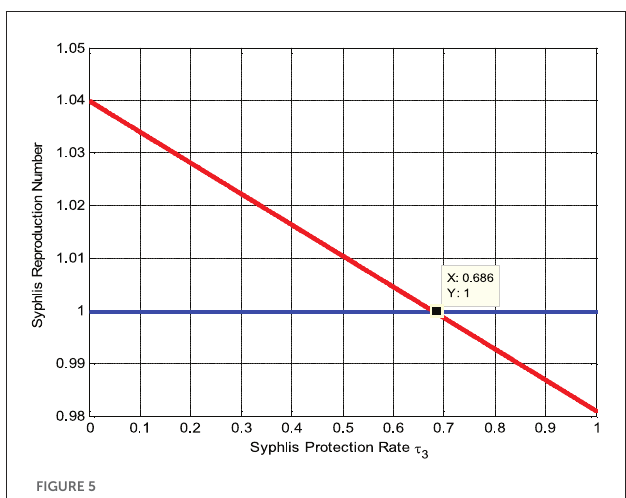
FIGURE5 Effect of syphilis protection rate τ 3 on R s 0 .